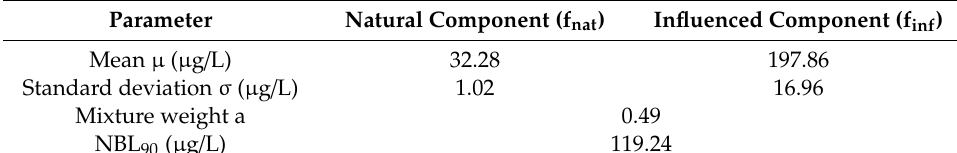
Table 1. GuEstNBL output: Results of the guided estimation procedure for arsenic dataset.